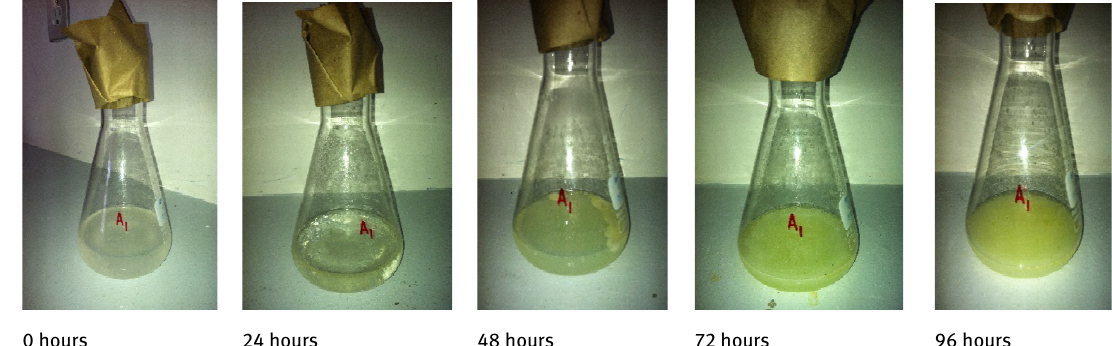
Figure 1: Growth of strains in solid medium results